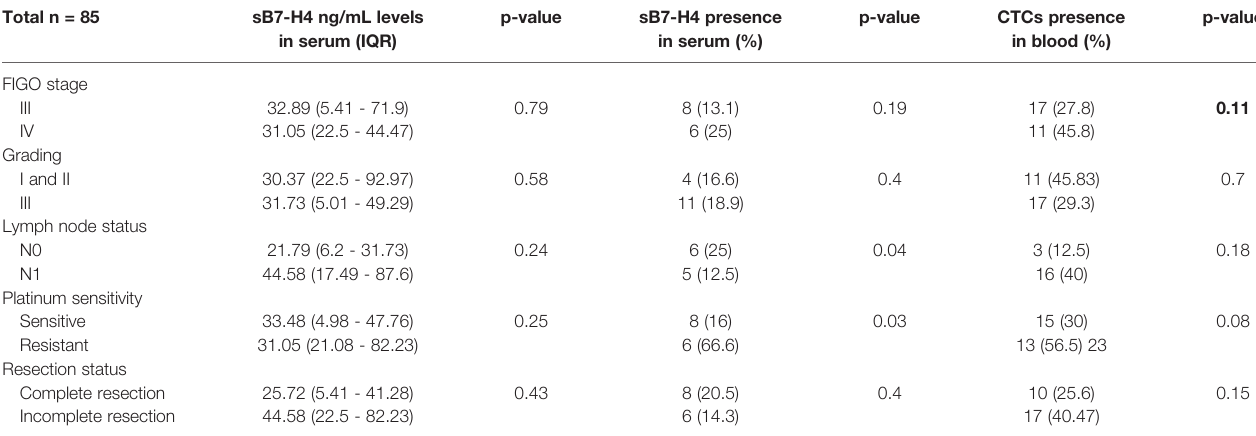
p-value sB7-H4 presence p-value CTCs presence p-value in serum (IQR) in serum (%) in blood (%)